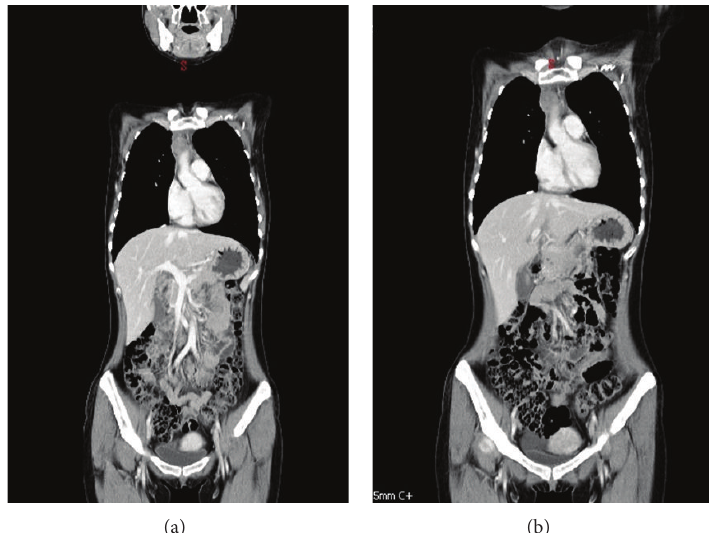
Figure 2: Mediastinal tumor refractory to salvage radiotherapy. (a) CT shows relapsed superior mediastinal tumor before radiotherapy. (b) CT reveals progression of the superior mediastinal tumor 2 months after completion of radiotherapy.